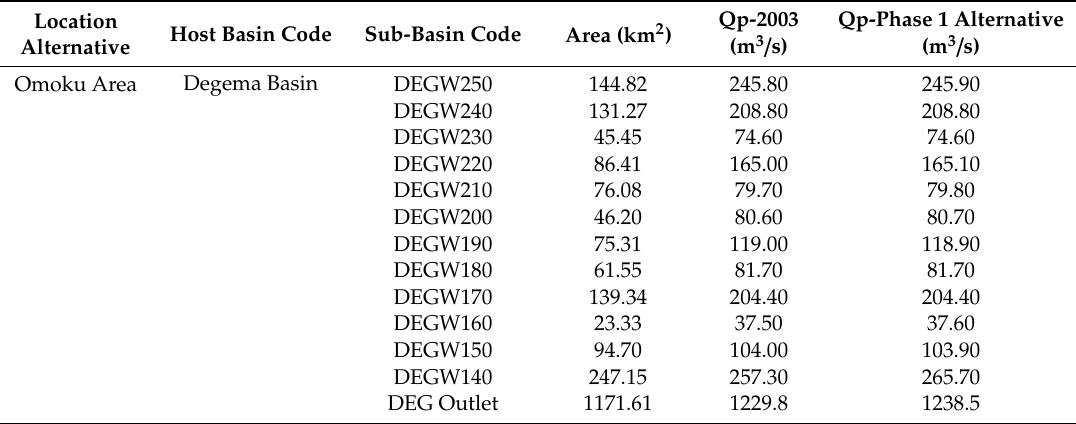
Table 6. Modelled result of peak flow responses to Port-Harcourt Alternative in DEG = Degema; Qp = Peak discharge; Qp-2003 = Peak discharge based on year 2003 LULC condition; Qp-Phase 1 Alternative = Peak discharge based on Phase 1 alternative LULC condition.